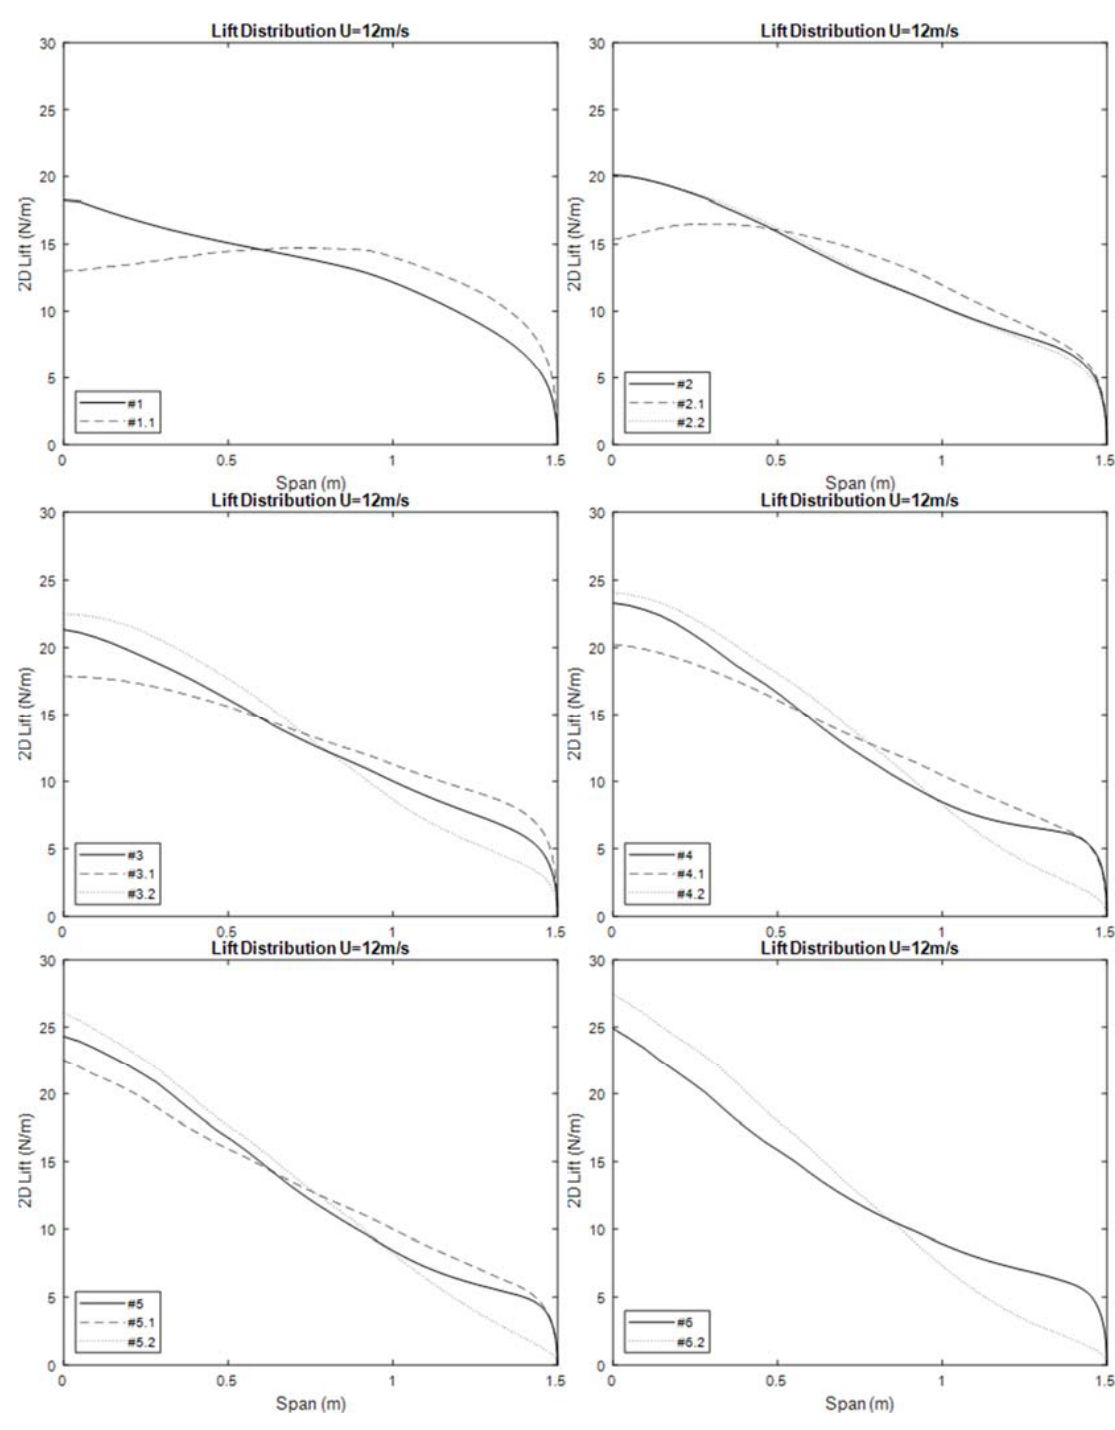
Figure 11. Spanwise lift distributions of the selected configurations.